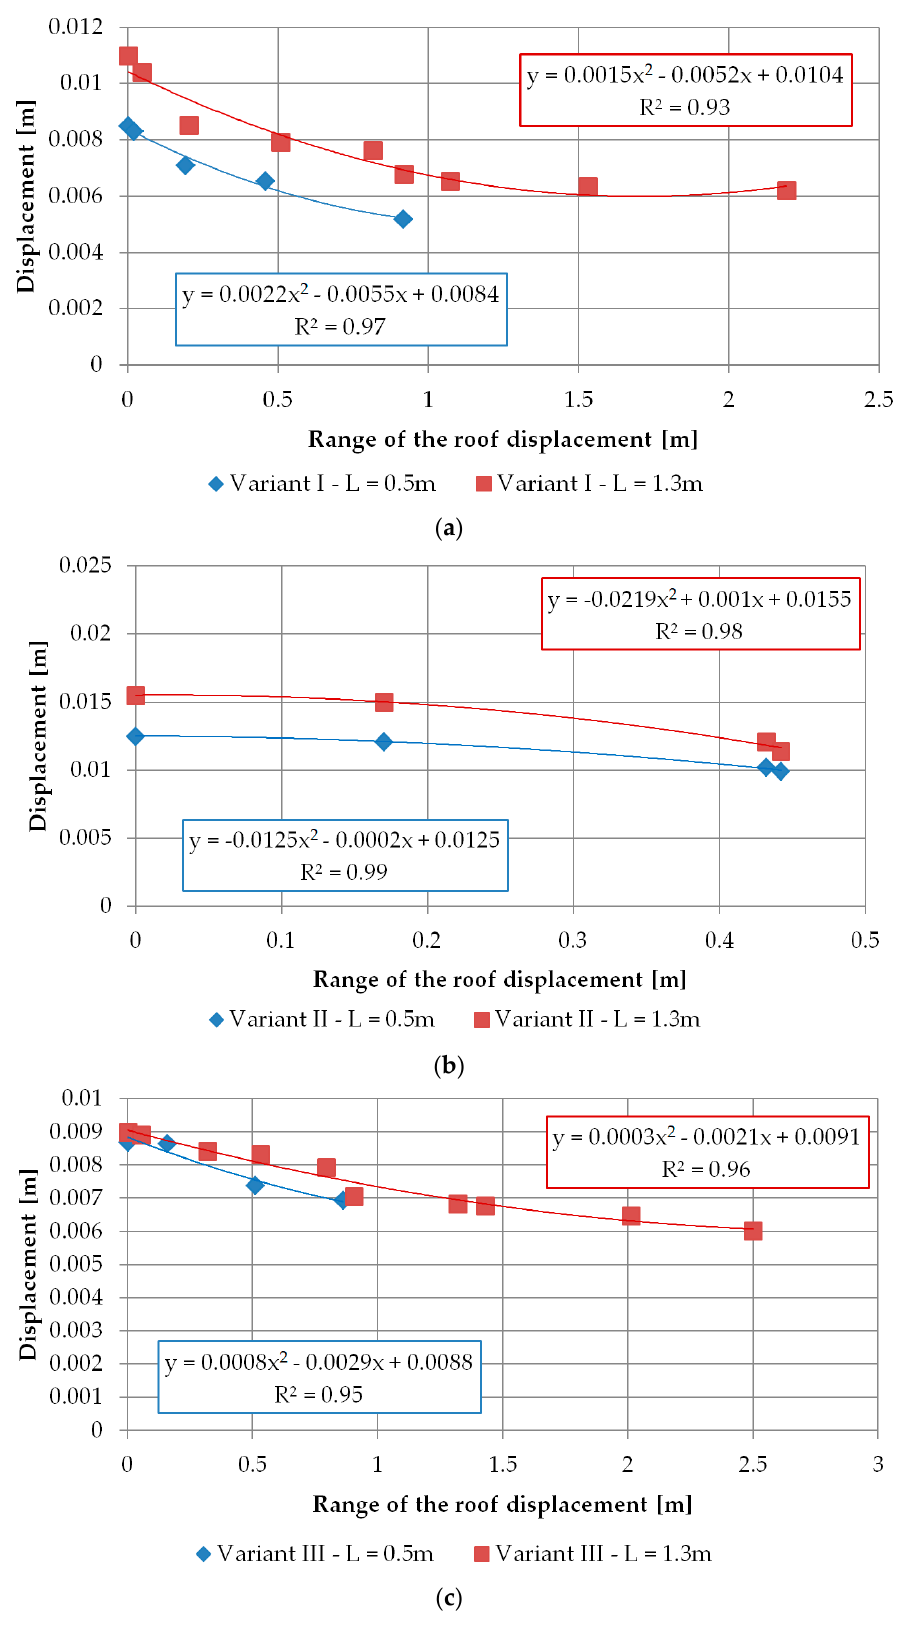
Figure 12. Changes in the range of roof displacement an displacement in the roof of longwall working depending on the distance from coal face: ( a )—variant I, ( b )—variant II, ( c )—variant III.